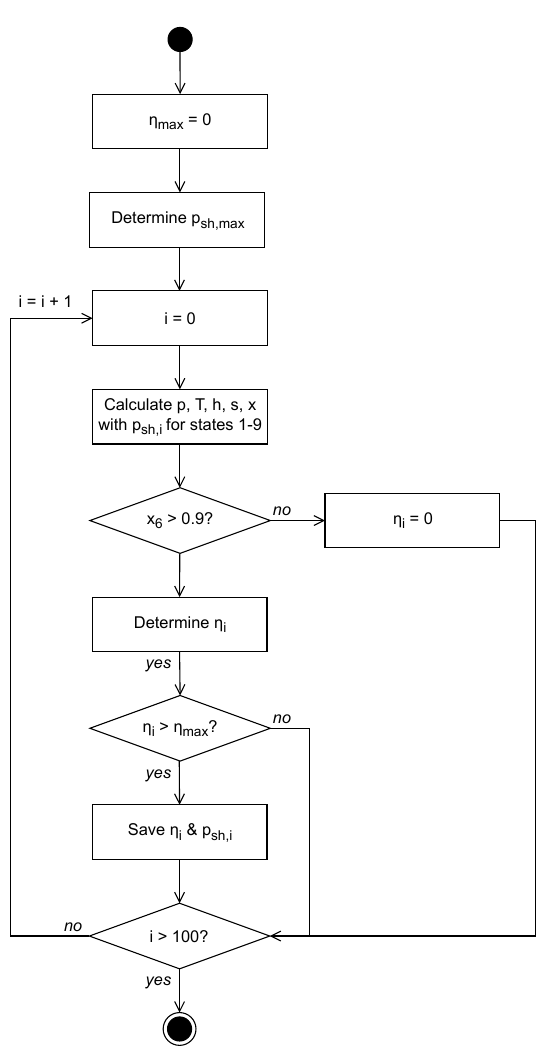
Figure 2. Flowchart to determine the maximum performance and the super-heater